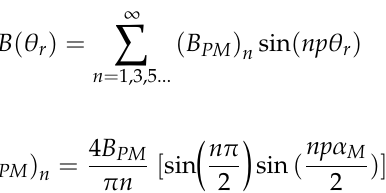
Figure 3. Ideal airgap flux density generated by the rotor surface mounted PM ( B PM ) presented over a pole-pair pitch [29].